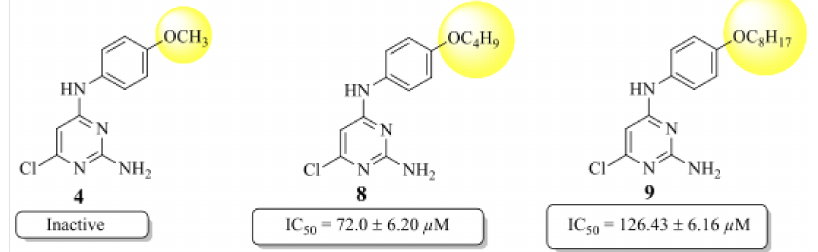
Figure 4. Comparison of β -glucuronidase inhibitory activity of compounds with a 4-alkoxy substitu- tion at the benzene